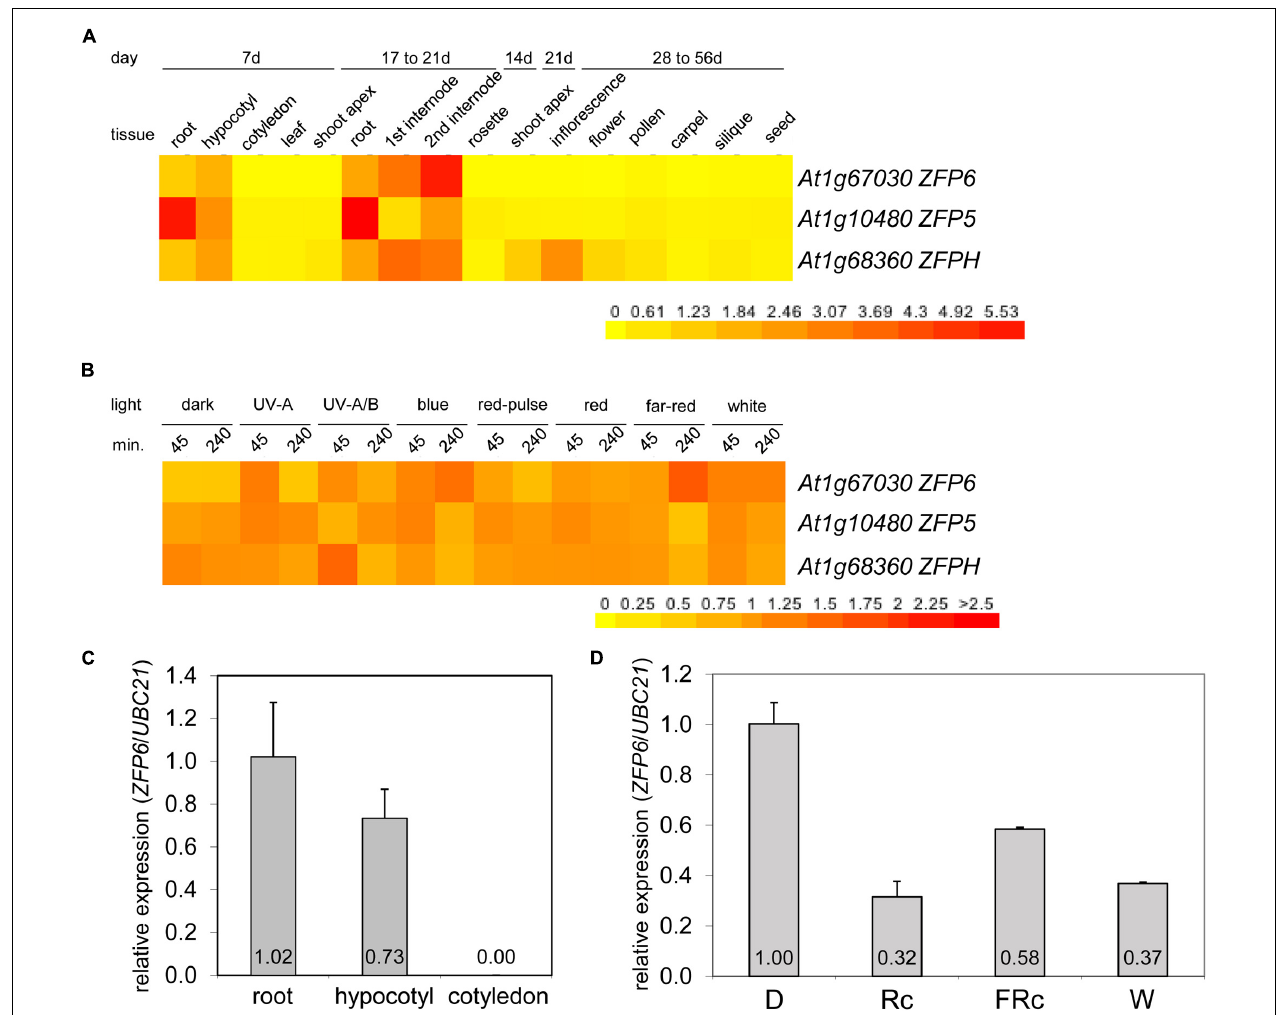
FIGURE 2 | Expression of ZFP6 , ZFP5 , and ZFPH in different tissues and light conditions. Heat map showing the expression of ZFP6 , ZFP5 , and ZFPH in (A) different tissues or (B) different light conditions for Arabidopsis. For heat map, mean-normalized values of Col-0 WT from AtGenExpress expression library and BAR Heatmapper Plus (bar.utoronto.ca) were used. For light experiments in panel (B) , aerial parts (hypocotyl and cotyledons) of 4-days-old Col-0 WT seedling grown on MS medium were treated with different light for either 45 or 240 min. (C) qRT-PCR analysis of ZFP6 expression in Col-0 WT root, hypocotyl, or cotyledon tissues from seedlings grown on MS medium containing 1% sucrose and 0.7% Phytoblend agar at 22 ◦ C for 7 days under white light (W) at 100 µ mol m − 2 s − 1 . (D) ZFP6 expression analyses in Col-0 WT grown as mentioned in (C) but under dark, continuous red (Rc; 50 µ mol m − 2 s − 1 ), continuous far-red (FRc; 5 µ mol m − 2 s − 1 ),